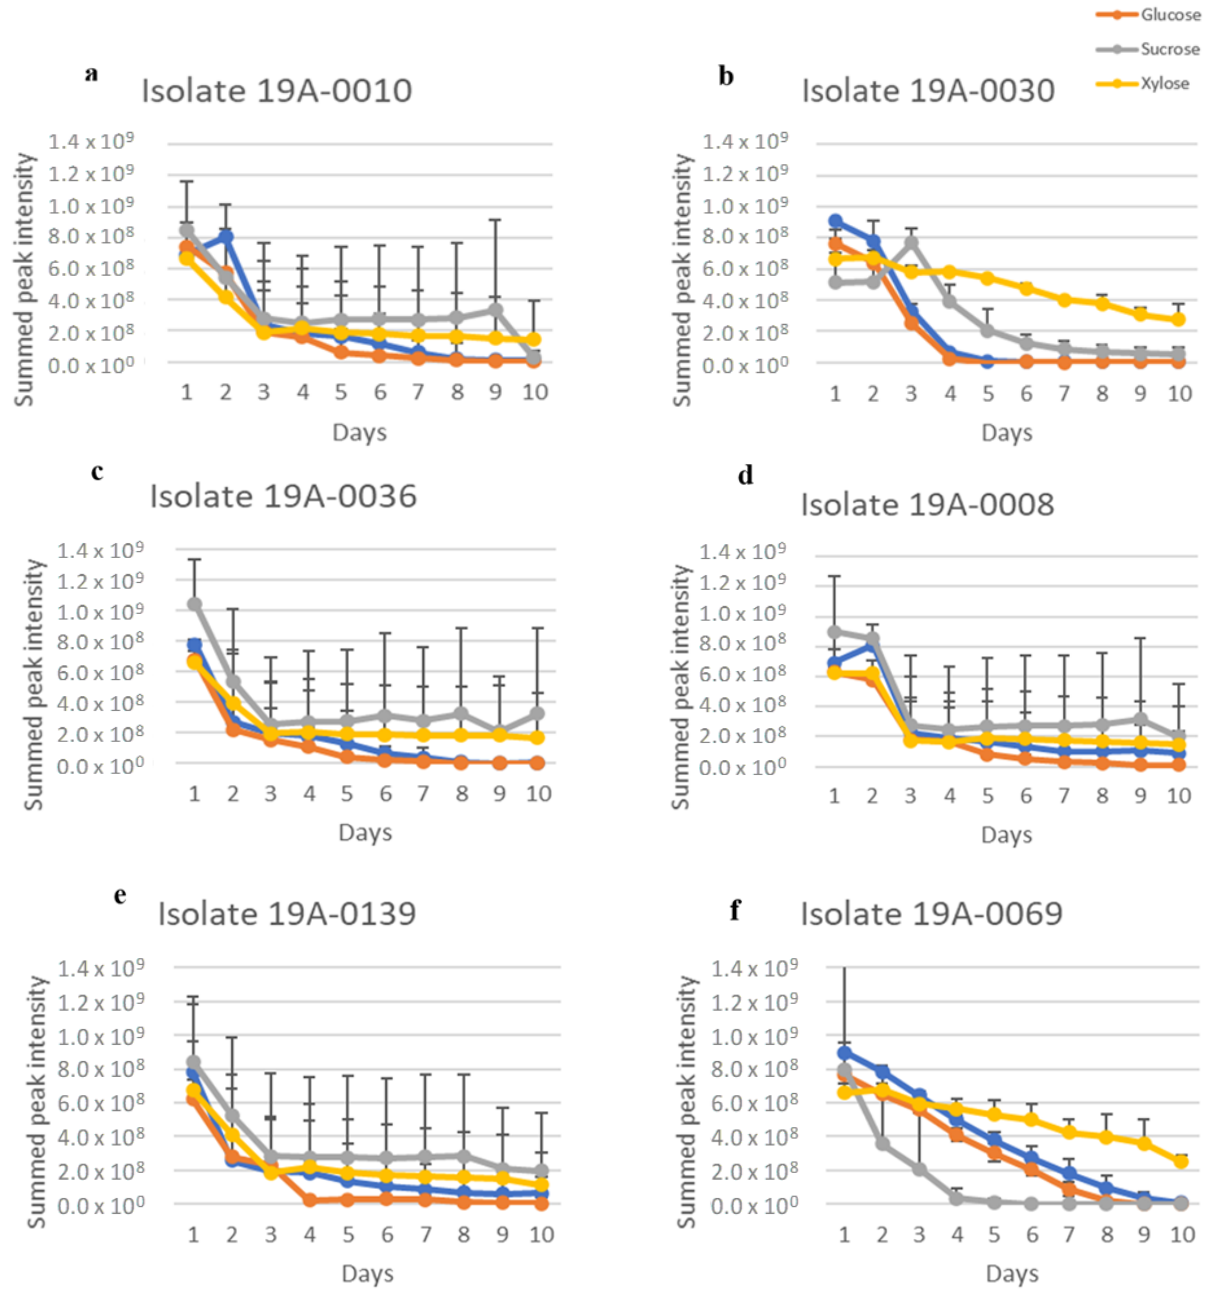
Figure 3. Sugar metabolisation of R. stolonifer isolates in the presence of NH 4 (SO 4 ) 2 as the nitrogen source. Data presented are the relative concentration of sugar (as determined from NMR) with standard deviation (error bars), n = 3. ( a ) Isolate 19A – 0010, ( b ) isolate 19A – 0030, ( c ) isolate 19A – 0036, ( d ) isolate 19A – 0008, ( e ) isolate 19A – 0139, ( f ) isolate 19A – 0069.